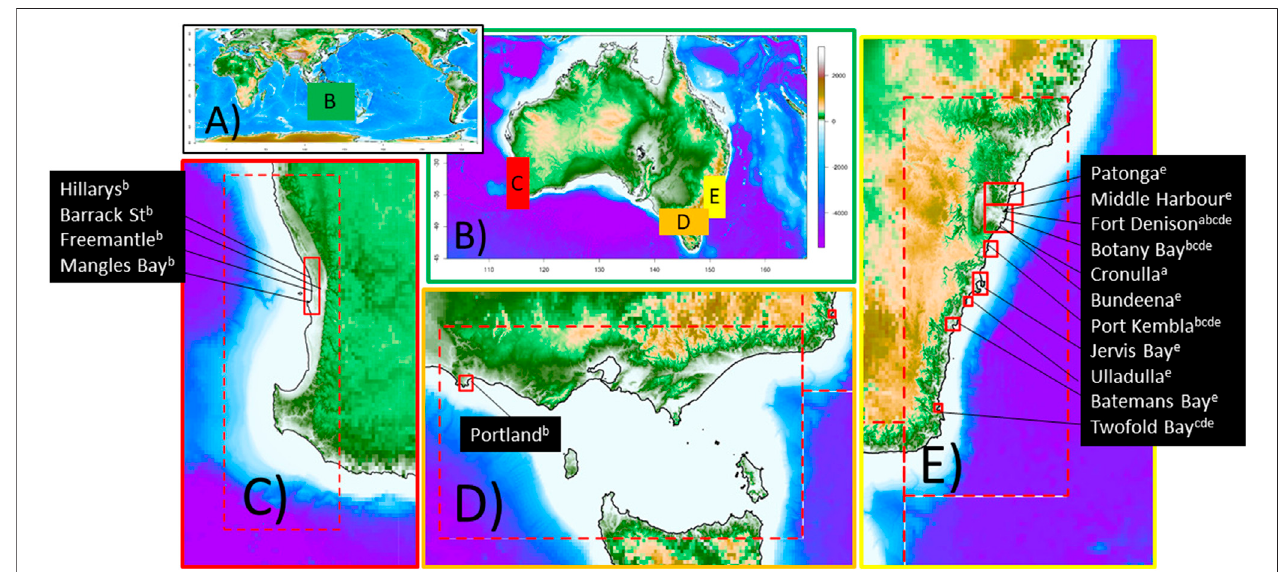
FIGURE3| Themodelextentandtide-gaugelocations.Superscriptsontide-gauges(a,b,c,d,e)indicatethetsunamisforwhichwehavedata,correspondingtothe 1960, 2004, 2010, 2011, 2015 events, respectively. (A) The global grid has a spatial resolution of 1-arc-minute and is modeled with reduced-physics approaches; (B) zoom near Australia which shows the three regions where re fi ned grids are used and the NSWE are solved; (C – E) the re fi ned grids around western and south-eastern Australia. Dashed boxes denote regions with 1/7-arc-minute spatial resolution ( x 260 m), and solid boxes denote regions with 1/49-arc-minute resolution ( x 37 m) which contain the tide-gauges.